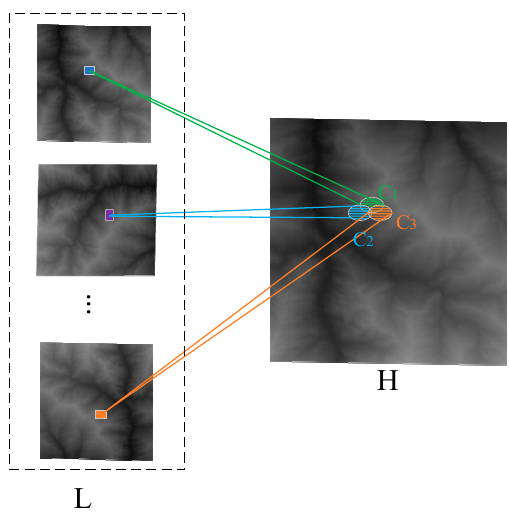
Figure 1. The linear constraint of low ‐ resolution DEM patches on high ‐ resolution DEM.